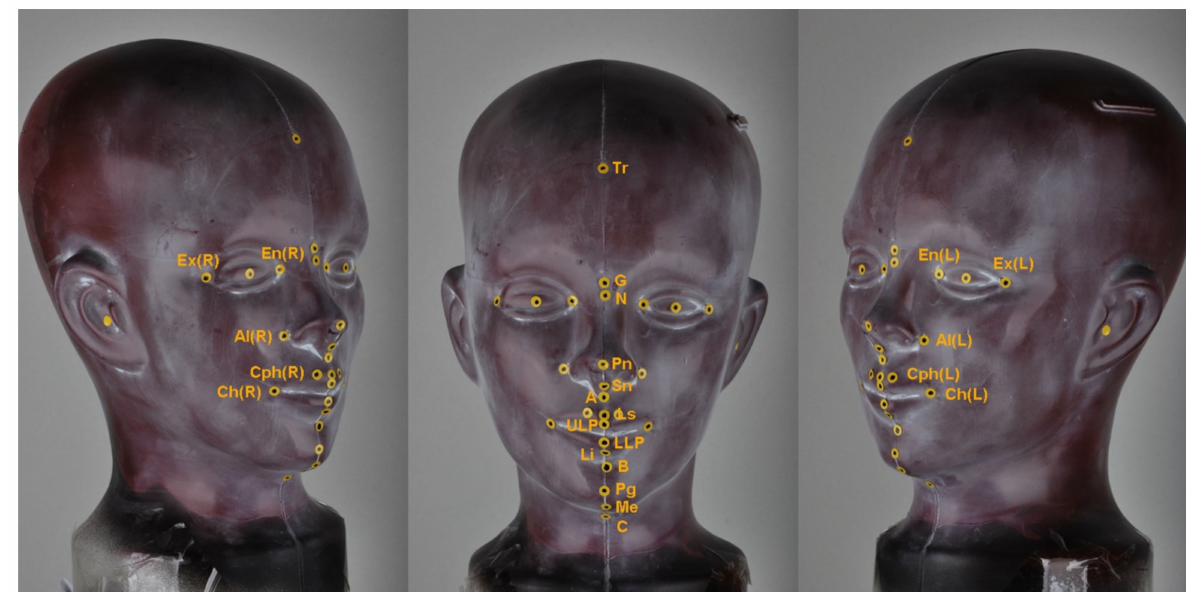
Figure 1. Soft tissue landmarks used in this study: Ex (R), exocanthion on the right side; Ex (L), exocantion on the left side; En (R), endocanthion on the right side; En (L), endocanthion on the left side; Tr, trichion; G, glabella; N, nasion; Pn, pronasale; Sn, subnasale; Al (R), alare on the right side; Al (L), alare on the left side; A, A point; ULP, upper lip point; LLP, lower lip point; B, B point; Pg, pogonion; Gn, gnathion; Me, menton; C, cervical point; Ls, labrale superius; Li, labrale inferius; Ch (R), cheilion on the right side; Ch (L), cheilion on the left side; Cph (R), crista philtre on the right side; Cph (L), crista philtre on the left.